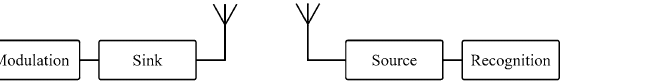
Figure 1. Wireless signal transmission and reception. At the transmitting end, the software radio module transmits the modulated signal through the Sink to transmit I/Q data to the antenna end. At the receiving end, the software radio module obtains the I/Q data of the antenna end from the Source .